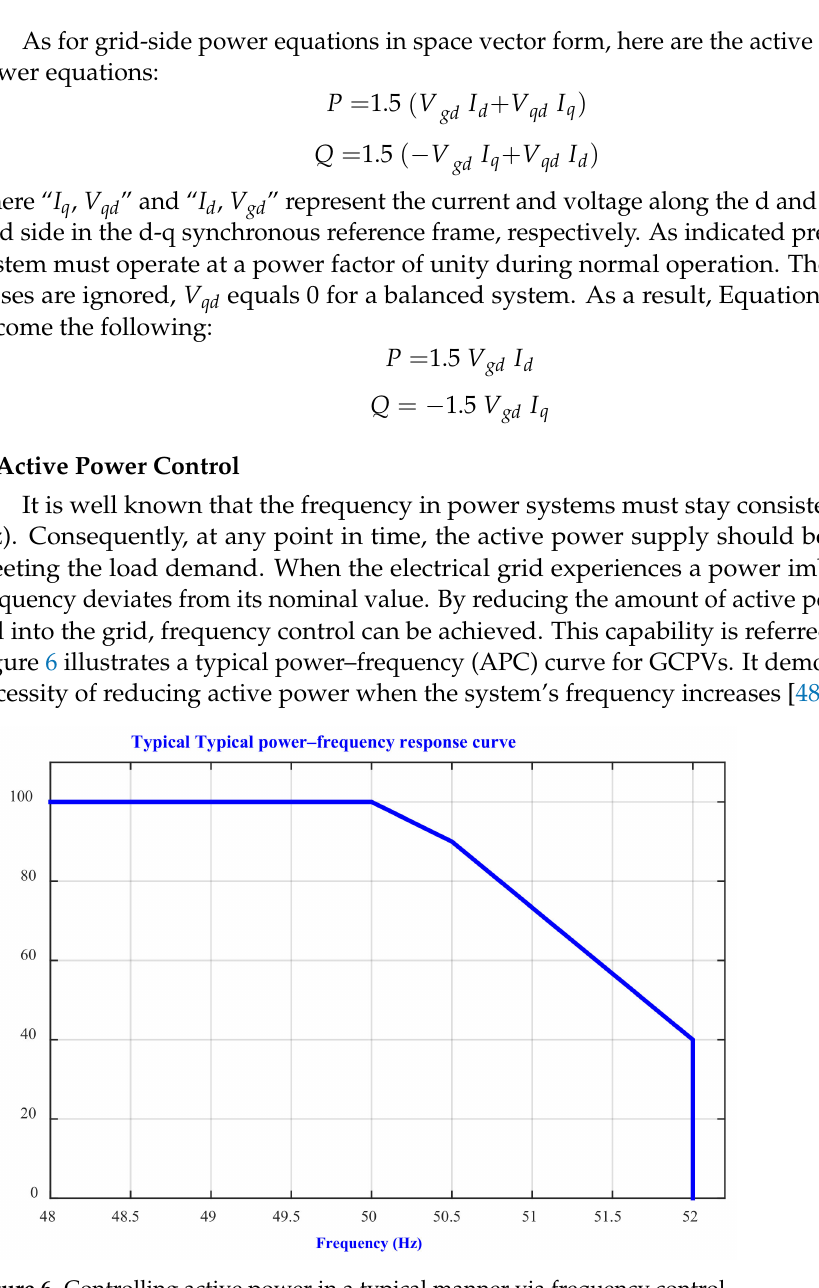
Figure 6. Controlling active power in a typical manner via frequency